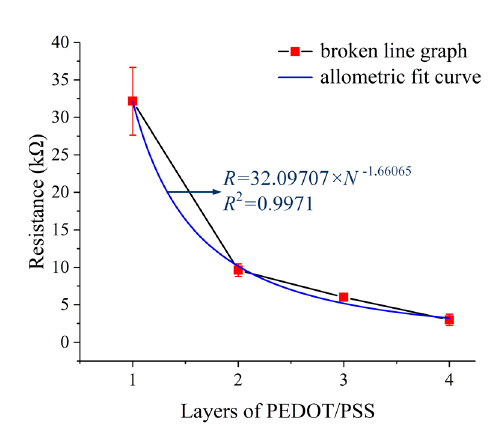
Figure 11. The resistance of the strain gauge versus printed layers.